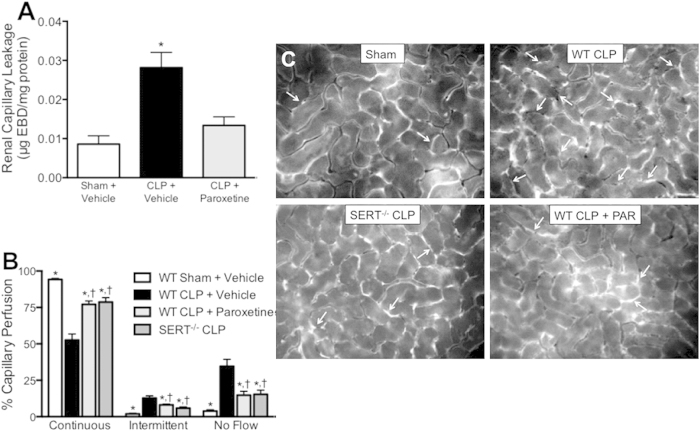
Role of SERT in vivo.Mice were made septic by CLP and microvascular leakage was assessed using Evans Blue dye at 4 h post-CLP (A) CLP produced a significant increase in kidney levels of Evans Blue dye, which was prevented by paroxetine (PAR, 4 mg/kg, ip) administered at the time of CLP (n = 4–5 mice/group). In separate experiments, renal cortical capillary perfusion was assessed using IVVM at 6 h post CLP (B) CLP produced a significant decline in perfusion, which was improved by PAR administered at the time of CLP. SERT−/− mice also had improved perfusion (n = 4–6 mice/group). Representative still images from the captured videos are presented in panel (C). White arrows point to capillaries with no blood flow. Data are mean ± SE. *P < 0.05 compared to WT CLP and †P < 0.05 compared to WT SHAM.